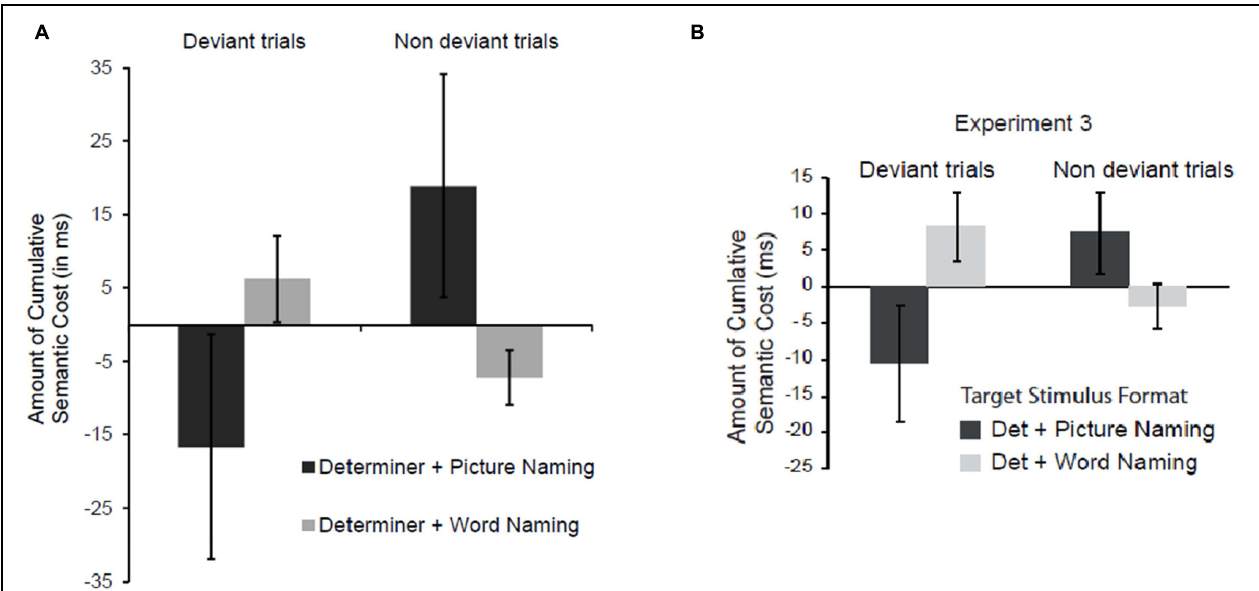
FIGURE 1 | (A) Mean differences in naming latencies representing the amount of transfer of interference observed for deviant and non-deviant trials (i.e., in the fourth ordinal position), for pictures and word targets. The difference was computed as the difference score between trials at the fourth ordinal position and trials at the third ordinal position within the same format (i.e., picture or word). Specifically, for deviant picture targets we calculated the difference scores between deviant trials (i.e., fourth ordinal position in the WWW-P condition) and trials in ‘ n-1 ’ ordinal position (i.e., third ordinal position in the PPP-P condition); while for non-deviant picture targets we calculated the difference scores between non-deviant trials (i.e., fourth ordinal position in the PPP-P condition) and trials in ‘ n-1 ’ ordinal position (i.e., third ordinal position in the PPP-P condition). The same was done for word trials. For deviant word targets we calculated the difference scores between deviant trials (i.e., fourth ordinal position in the PPP-W condition) and trials in ‘ n-1 ’ ordinal position (i.e., third ordinal position in the WWW-W condition); while for non-deviant word targets we calculated the difference scores between non-deviant trials (i.e., fourth ordinal position in the WWW-W condition) and trials in ‘ n-1 ’ ordinal position (i.e., third ordinal position in the WWW-W condition). Difference scores were calculated on a subject-by-subject basis (see Navarrete et al., 2010 for details). A positive value reflects a transfer of interference for consecutive ordinal positions within-category. (B) Transfer effects reported by (Navarrete et al., 2010; Experiment